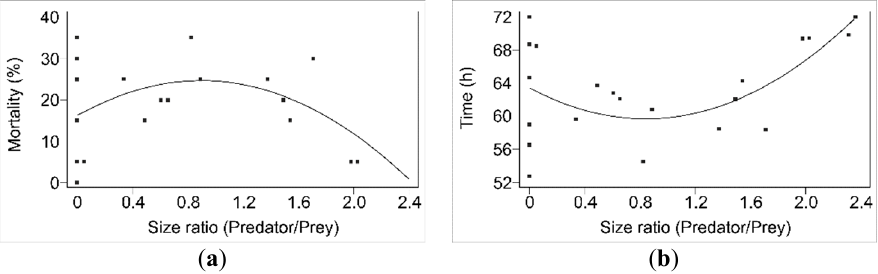
Figure A2. Relationship between mortality (%) ( a ) and survival time (h) ( b ) of Nesidiocoris tenuis as a function of the size ratio between cannibal and prey.